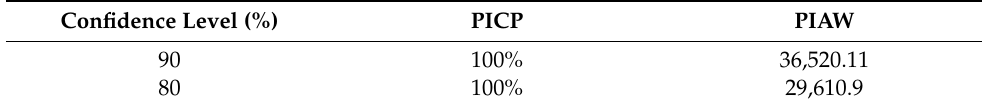
Table 5. Evaluation indicators of kernel density estimation.